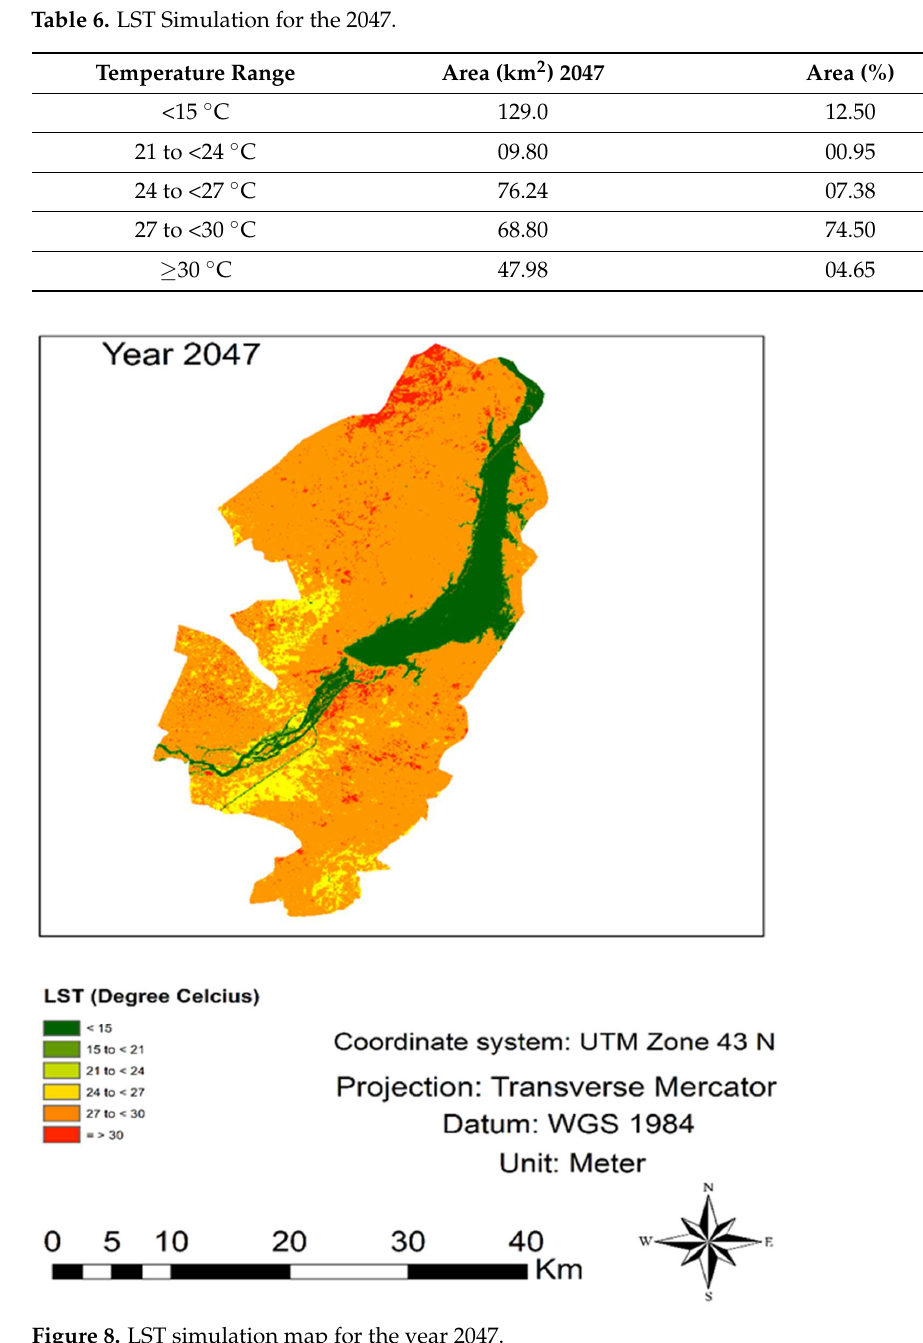
Figure 8. LST simulation map for the year